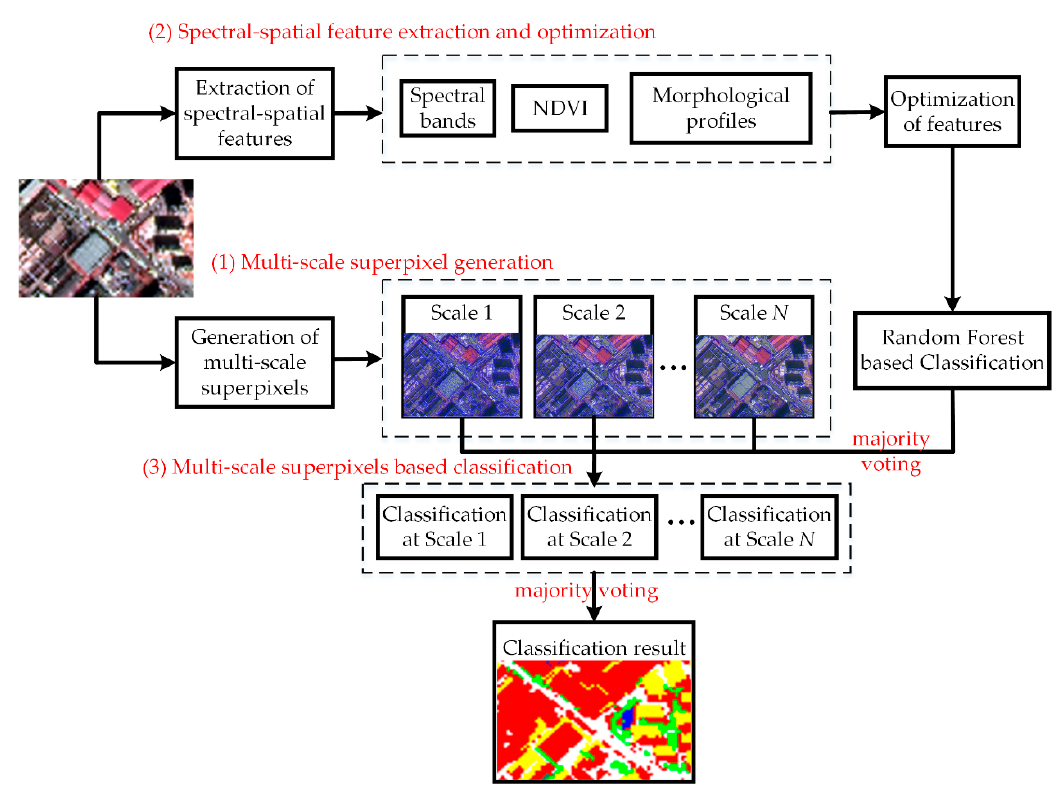
Figure 1. Framework of the proposed OSS-MSSC (Multi-Scale Superpixels-based Classification method using the Optimized Spectral–spatial features).